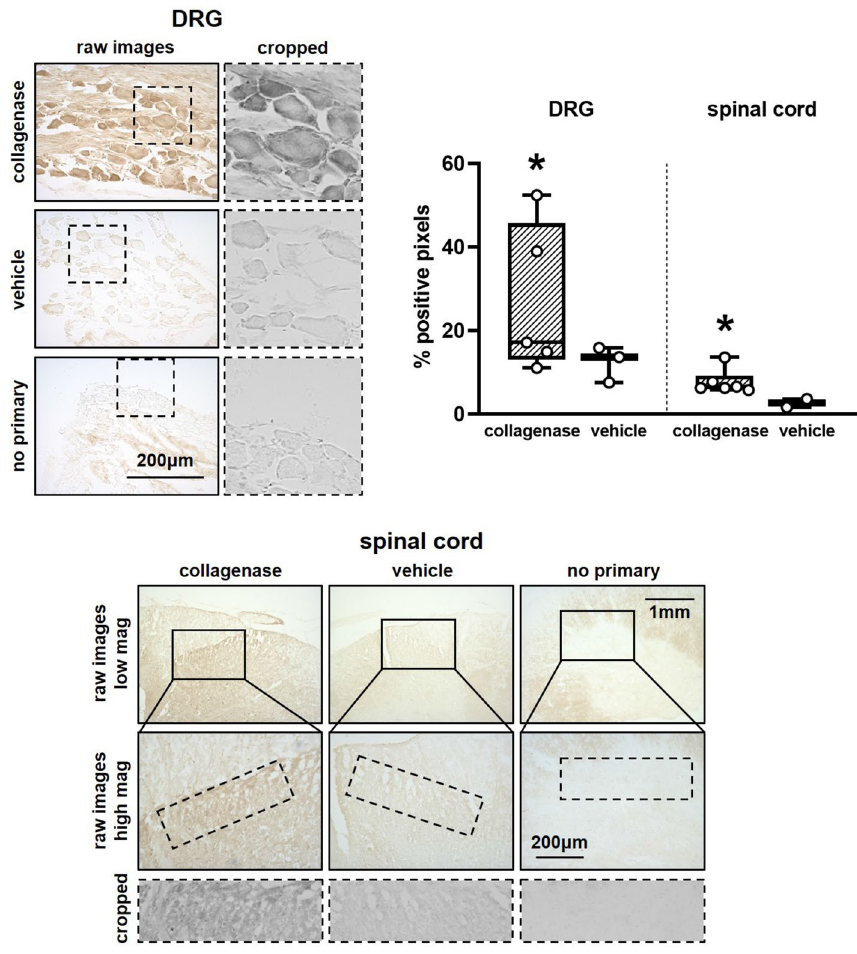
Figure 5. Detection of matrix metalloproteinase 1 (MMP-1) expression in the dorsal root ganglia (DRG) and spinal cord at day 21. Collagenase injection in the facet increases MMP-1 protein expression in the DRG (collagenase n = 5; vehicle n = 3; Wilcoxon test; *p = 0.039) with pronounced labeling in DRG cells. Dashed insets in the DRG images show representative cropped regions (600 × 600 pixels) where MMP-1 labeling is quantified in DRG cells. Spinal MMP-1 in the superficial dorsal horn is also greater with intra-articular collagenase (collagenase n = 6; vehicle n = 2; Wilcoxon test; *p = 0.041). Low magnification images (top) show the superficial spinal cord, from which high magnification images (middle) were acquired for quantification. Dashed insets in high magnification images show representative cropped (1500 × 500 pixels) regions where MMP-1 labeling is quantified in the superficial dorsal horn. Images of the no primary, negative controls are shown for both DRG and spinal cord labels. Box-and-whisker plots show horizontal lines representing the first (lower) quartile, median, and third (upper) quartile of the data. Data points for individual rats on boxplots represent the mean of 6–8 images/rat for each of the DRG and spinal cord